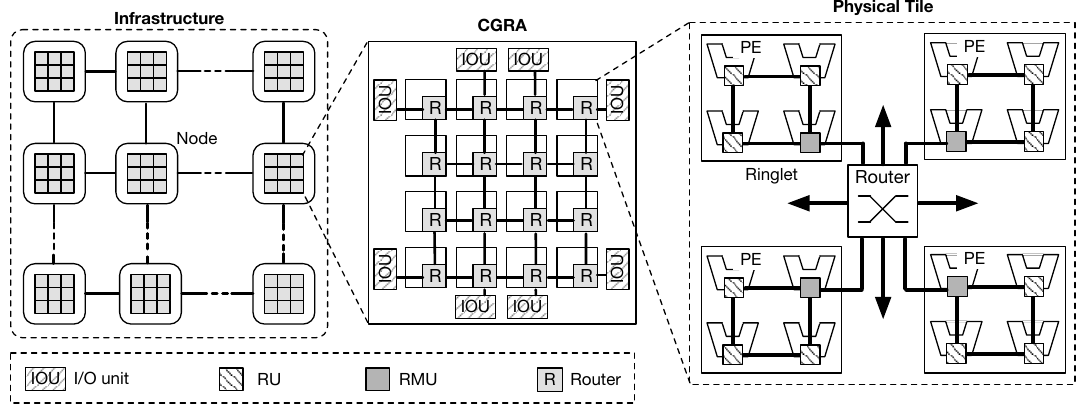
Figure 1. Overview of the proposed scalable network-on-chip fabric. Multi-node configurations exploit the availability of high-speed I/O